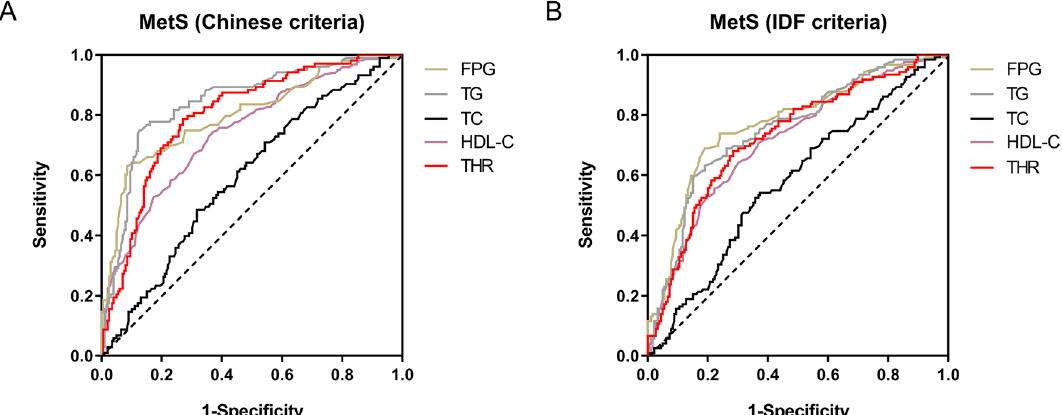
Figure 2. ROC curves of different parameters for MetS predicting. ( A ) ROC analysis of the THR for MetS predicting according to the Chinese criteria. The AUC of THR was 0.800 (95% CI 0.749–0.852). ( B ) ROC analysis of the THR for MetS predicting according to the IDF criteria. The AUC of the THR was 0.727 (95% CI 0.669–0.786). AUC area under the ROC curve, FPG fast plasma glucose, HDL-C high-density lipoprotein cholesterol, IDF international diabetes federation, MetS metabolic syndrome, ROC Receiver operating characteristic, TC total cholesterol, TG triglyceride, THR total cholesterol and high density lipoprotein cholesterol